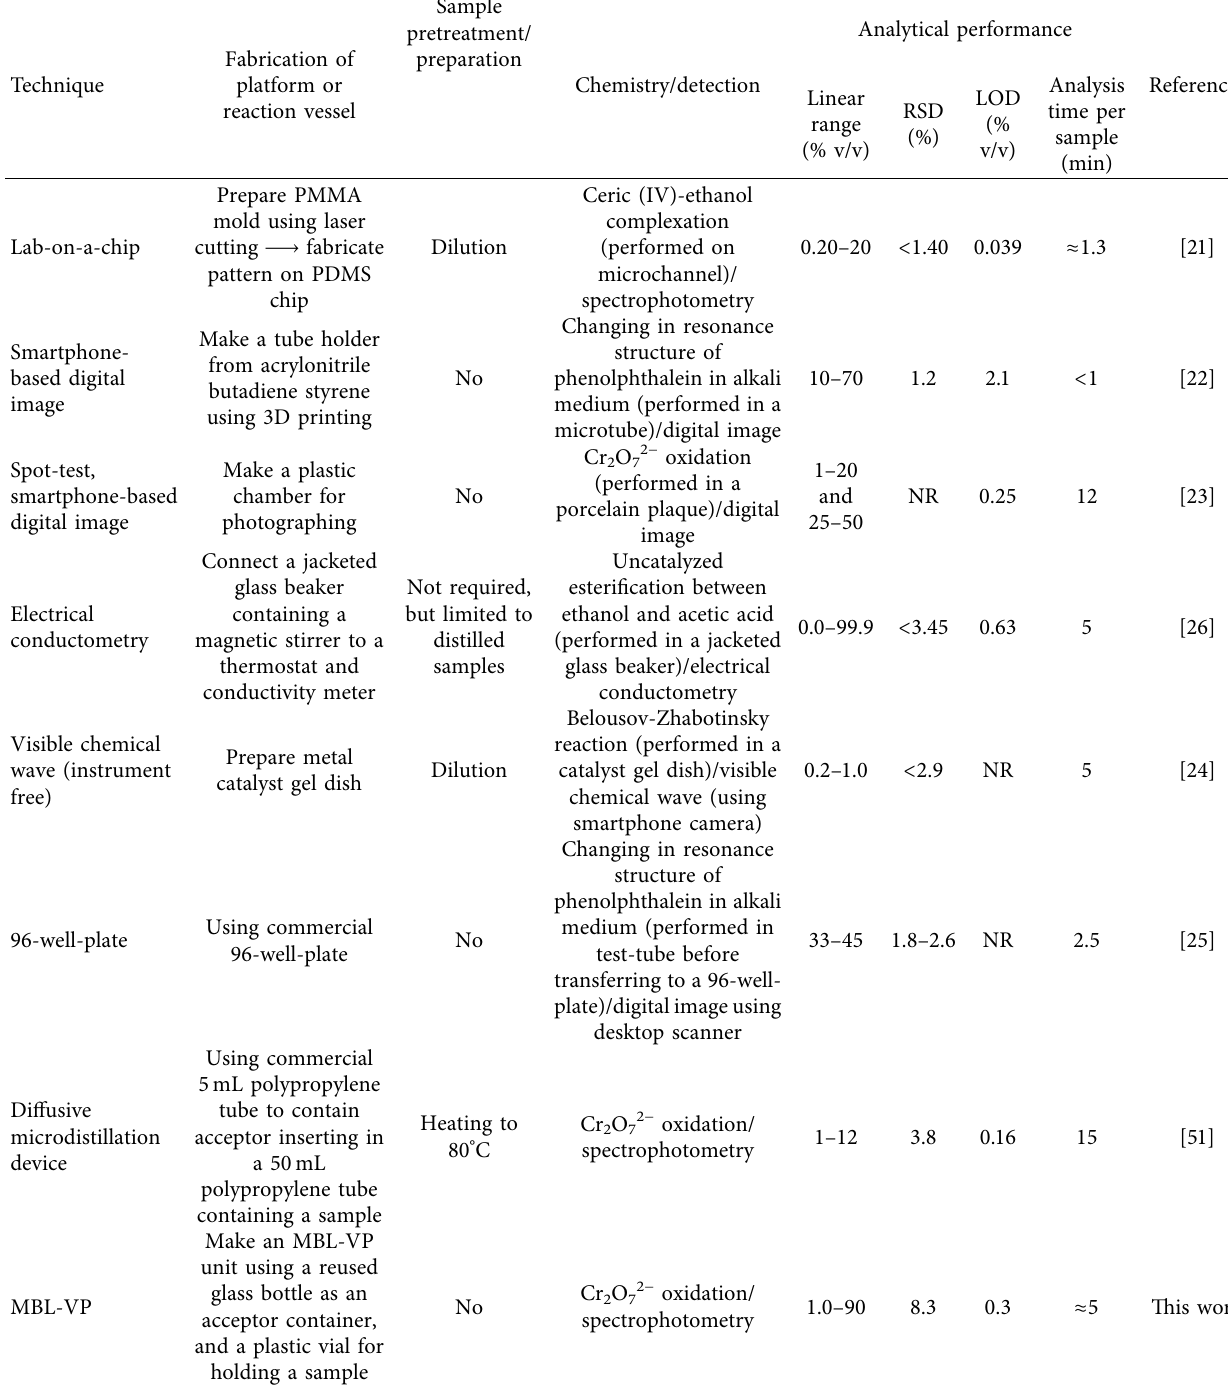
Table 2: Some analytical performance of the proposed MBL-VP unit and other simple and cost-effective approaches for quantification of ethanol in